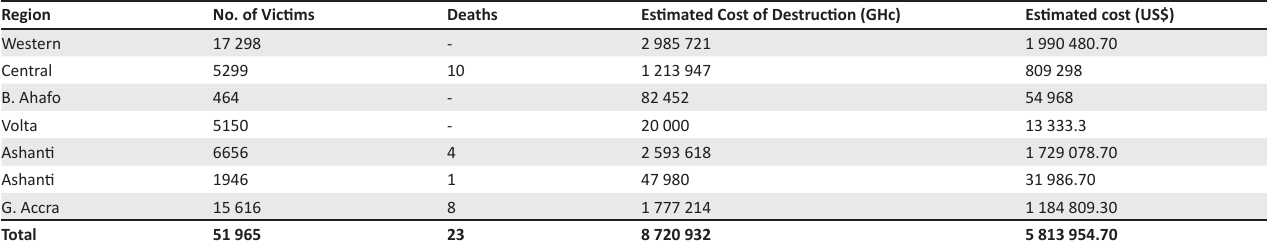
TABLE 1: Impact of June/July 2009 floods in southern Ghana.